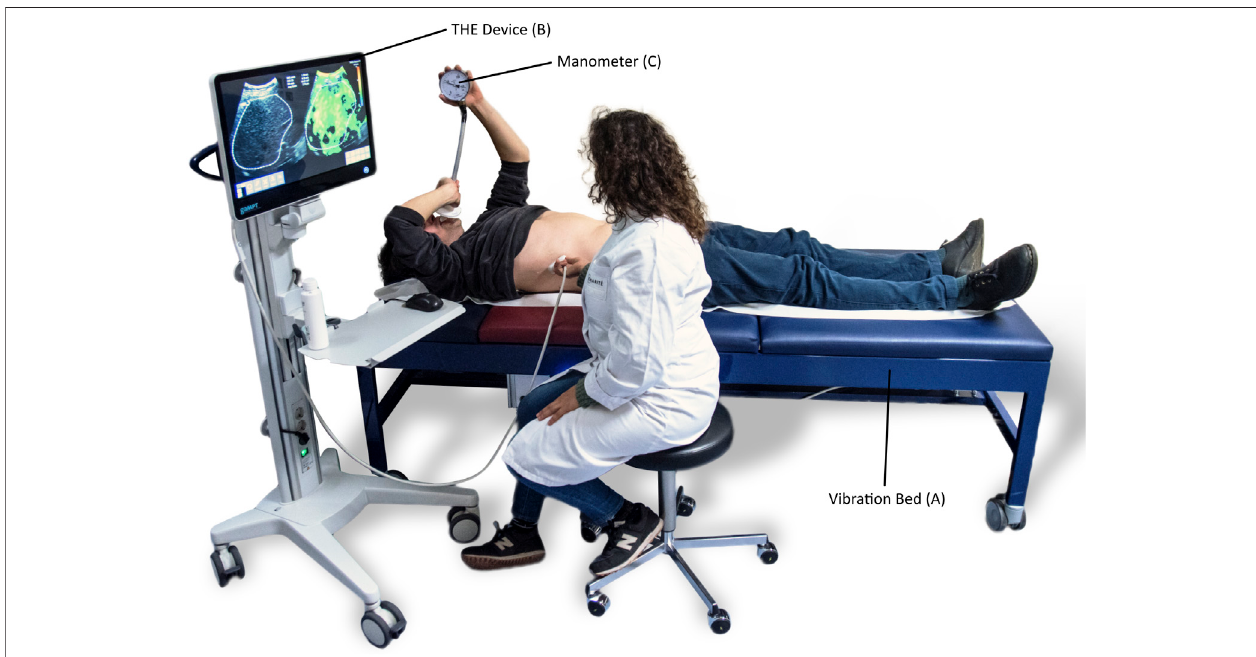
FIGURE 1 | Setup of time harmonic elastography (THE). (A) Vibration bed with integrated loudspeaker (underneath the red area of the bed) to induce harmonic vibrations. (B) THE device with integrated medical ultrasound system for data acquisition and elastography computer for generation of shear wave speed maps. (C) Manometer with mouthpiece to control expiratory pressure during the Valsalva